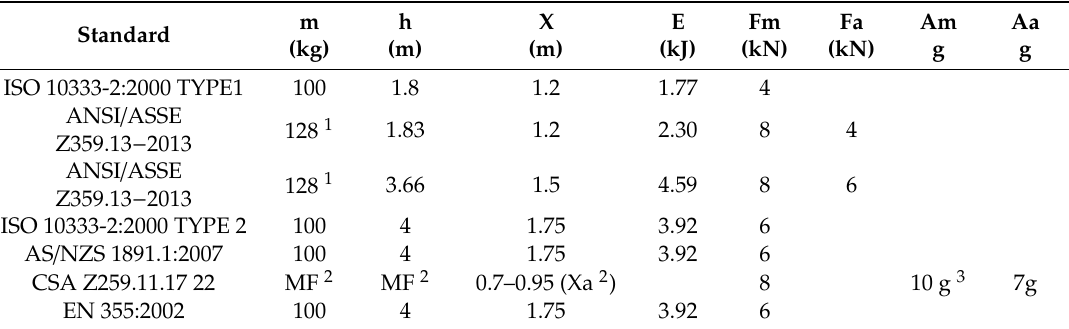
Table 1. Requirements of the di ff erent